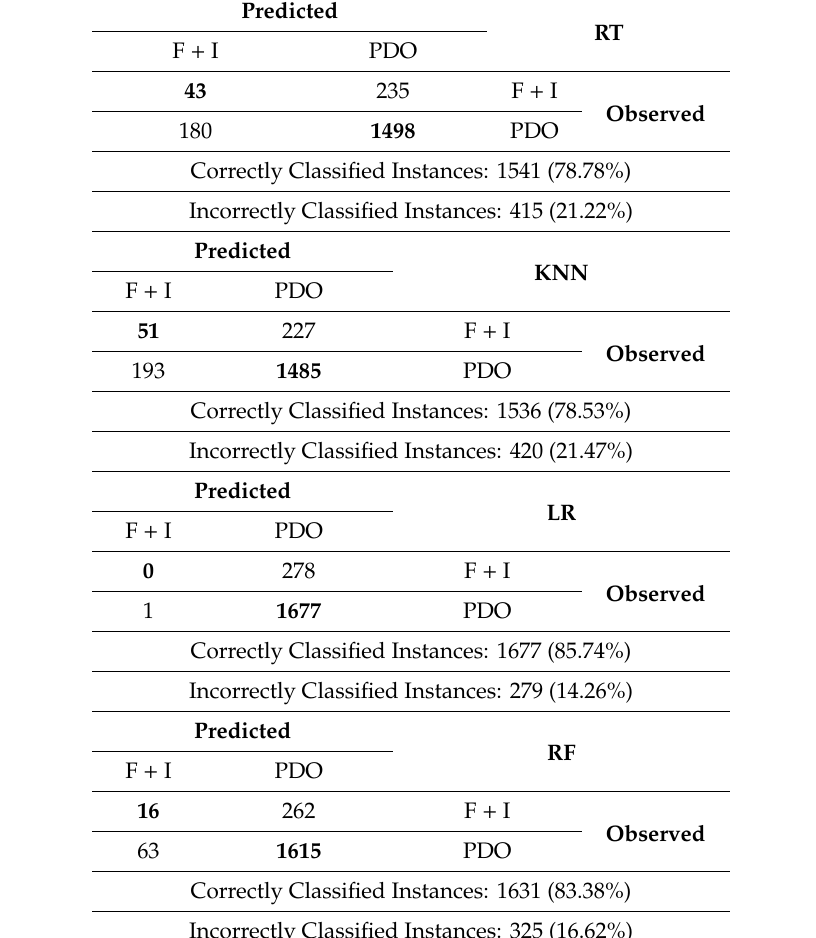
Table 5. Confusion matrices of the classifiers: RT, KNN, LR, and RF.